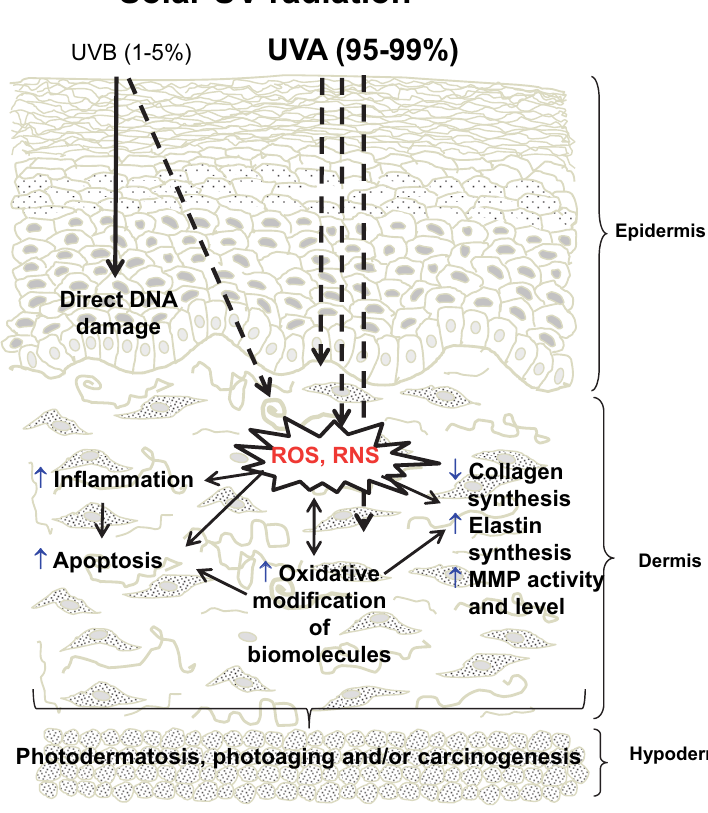
Fig. 1. Effects of solar UV radiation on skin